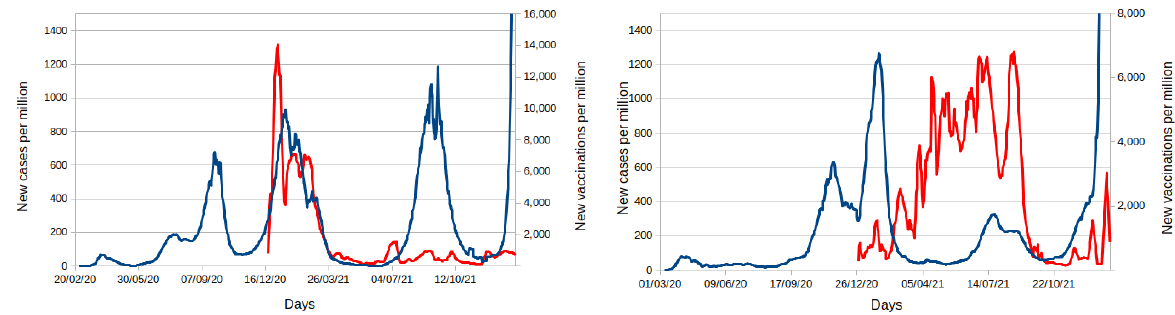
Figure 5. Real data for new cases (blue line) and new vaccinations (red line) for Israel (left plot) and Portugal (right plot). All curves are standardized per million and are not cumulative.